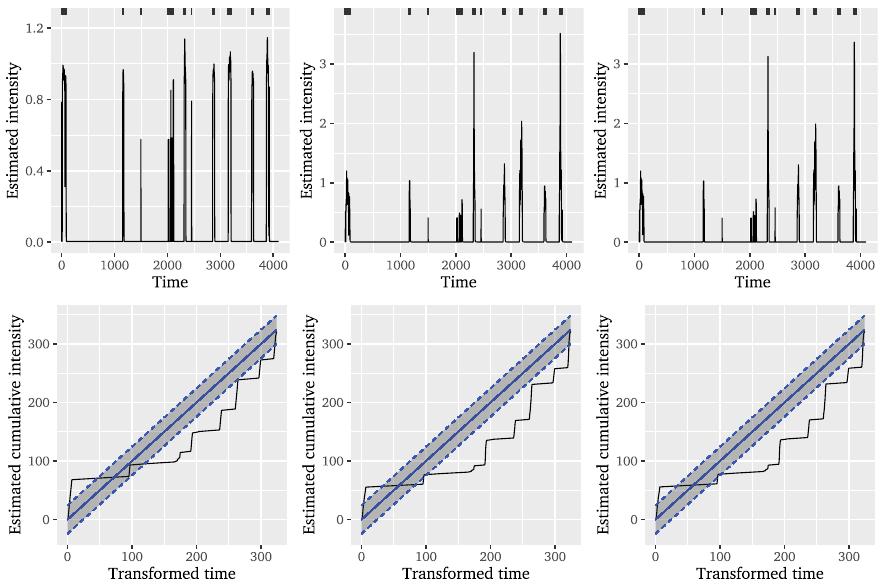
Figure A1. Estimated intensity and cumulative intensity of the Hawkes-POT model (with exponential decay) in the left column, the SEPOT model (with ETAS decay) in the middle column, and the SEPOT model (with exponential decay) in the right column. Ticks on the upper axis represent event occurrences. 95% confidence bands are based on the Kolmogorov–Smirnov statistic